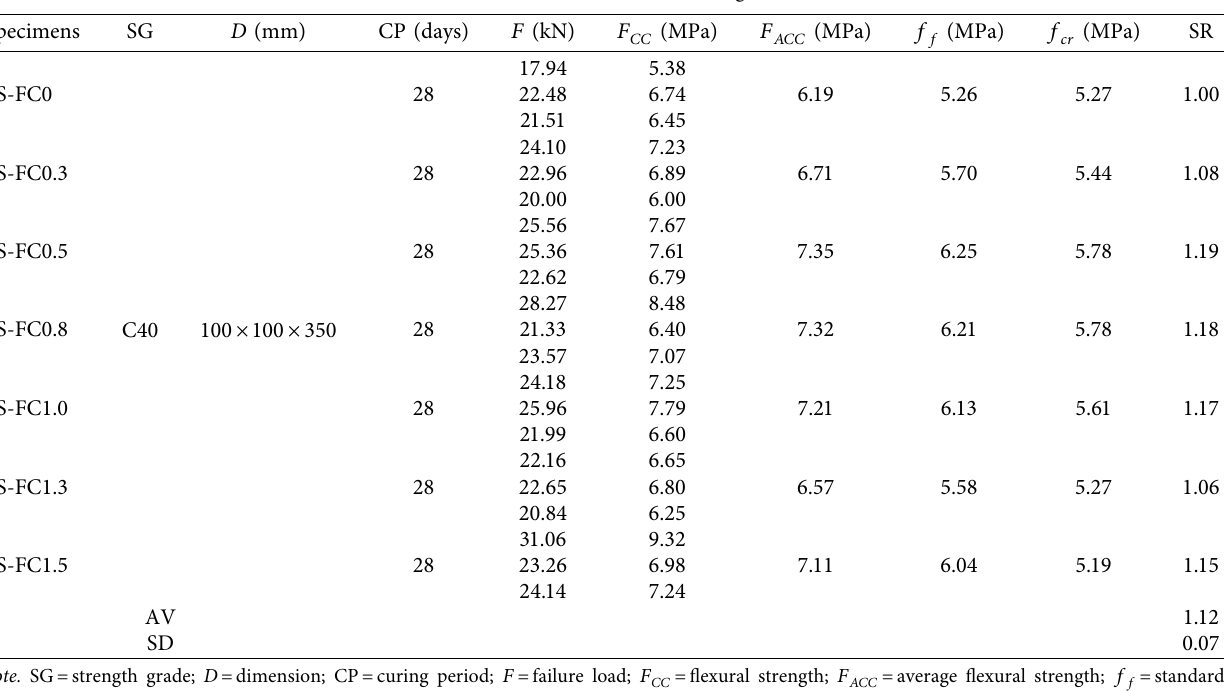
Table 3: ARGFRC fexural strength.